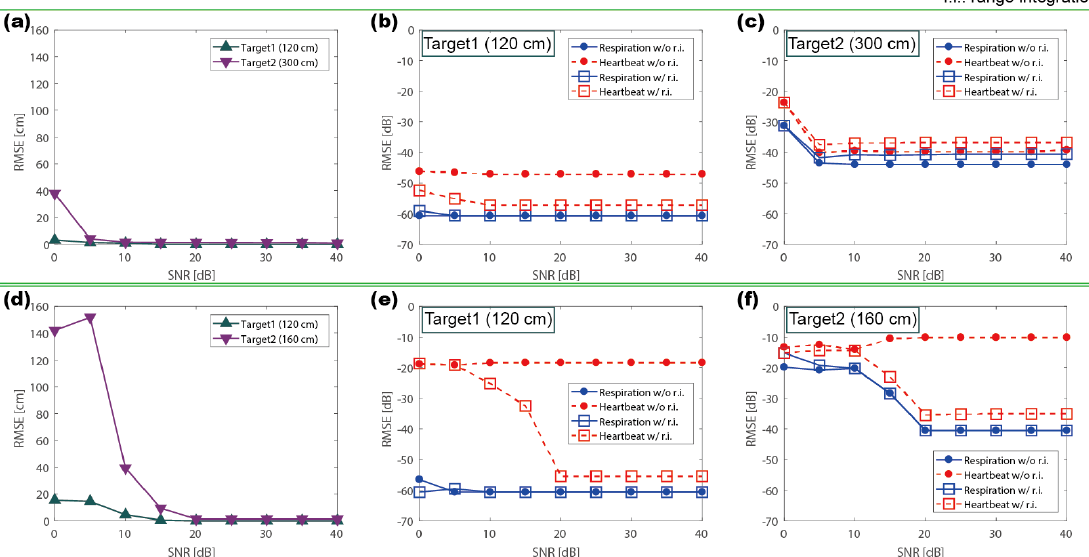
Figure 7. Root mean square error (RMSE) according to SNR for the proposed algorithm: ( a ) RMSE of range estimation at distances of 120 and 300 cm; ( b ) RMSE of heart rate and respiration detection for the front target at a distance of 120 cm (rear target: 300 cm); ( c ) RMSE of heart rate and respiration detection for the rear target at a distance of 300 cm (front target: 120 cm); ( d ) RMSE of range estimation at distances of 120 and 160 cm; ( e ) RMSE of heart rate and respiration detection for the front target at a distance of 120 cm (rear target: 160 cm); and ( f ) RMSE of heart rate and respiration detection for the rear target at a distance of 160 cm (front target: 120